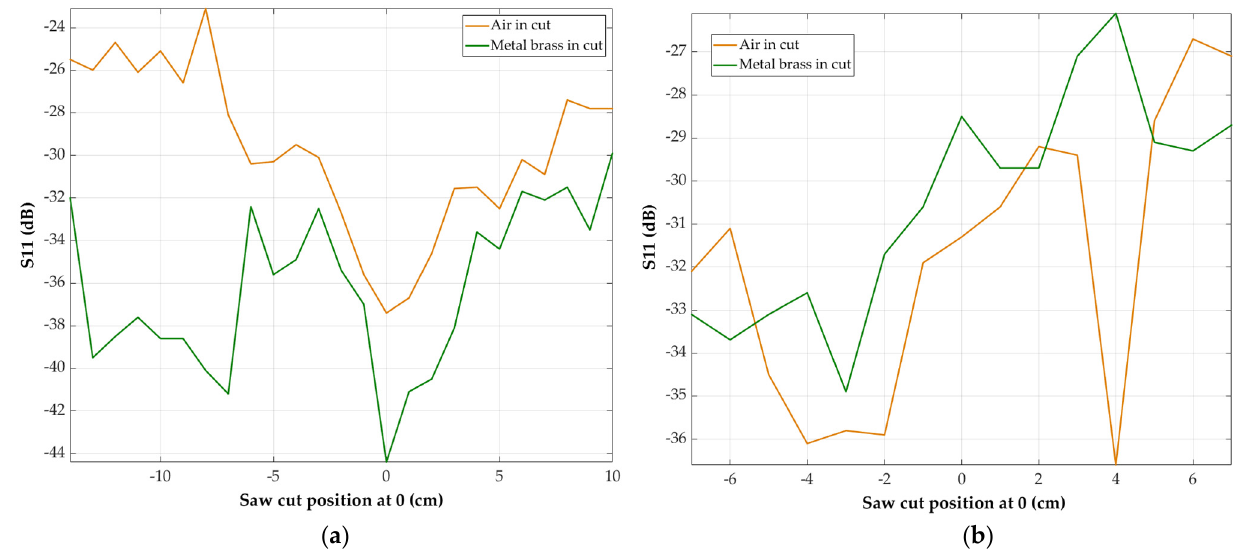
Figure 15. S 11 measurements for air vs. metal inside the saw cut located at position 0 in water-saturated wood: ( a ) E-field direction was parallel to the wood grain and perpendicular to the cut (reverse side); ( b ) E-field direction was perpendicular to the wood grain and parallel to the cut (reverse side).